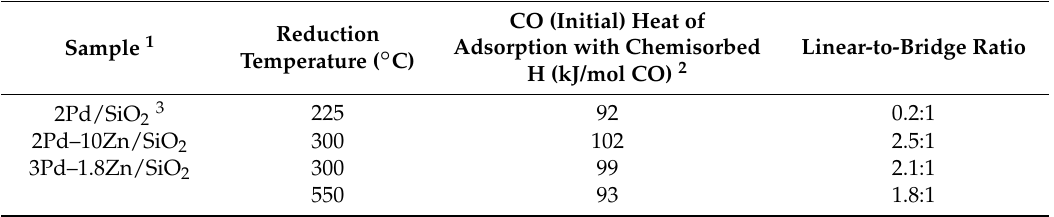
Table 1. Initial heat of CO adsorption values ( ± 5 kJ/mol) in the presence of chemisorbed hydrogen and linear-to-bridge ratios from DRIFTS. Reprinted from J. Catal., 318, D. J. Childers, N. M. Schweitzer, S. Mehdi Kamali Shahari, R. M. Rioux, J. T. Miller, R. J. Meyer, Modifying structure-sensitive reactions